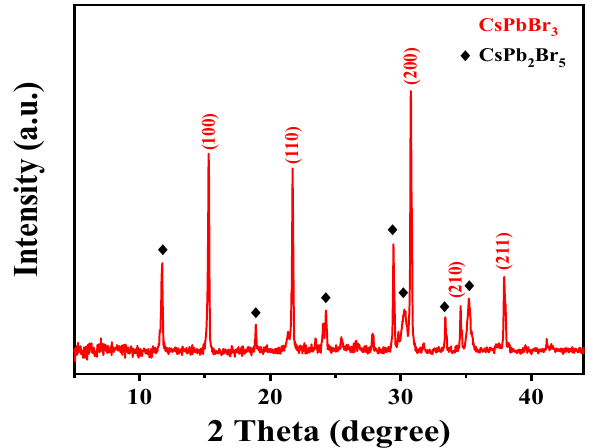
Figure 2. The X-ray diffraction spectra of the synthesized thin film.